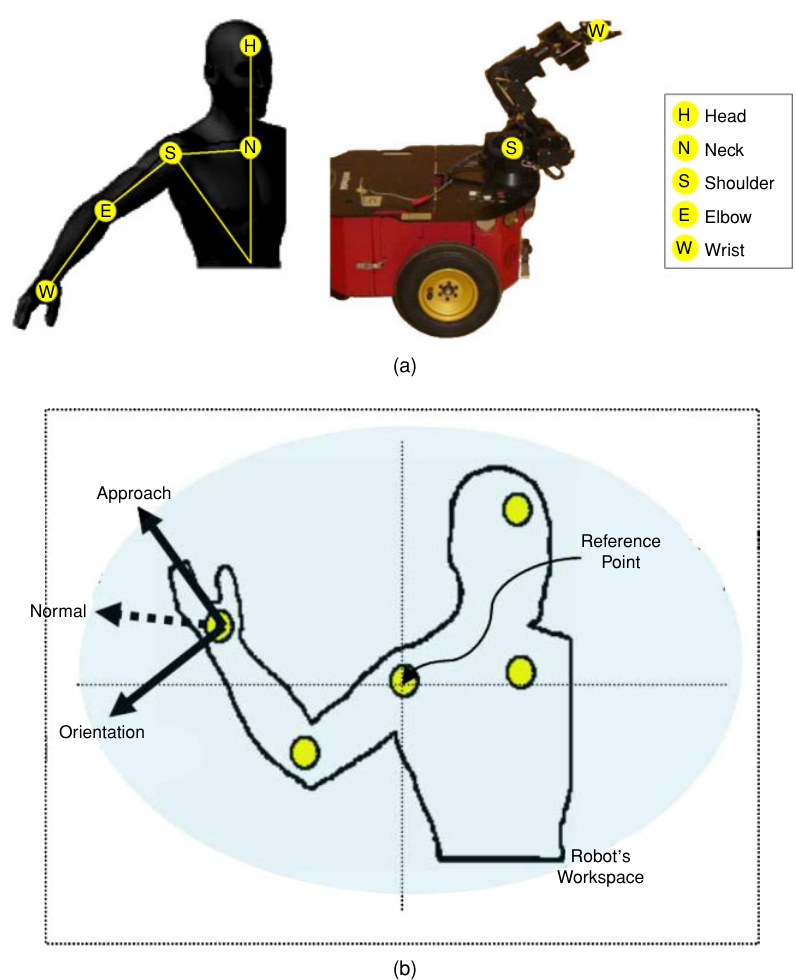
Figure 2 (a) The correspondence between the bodies of the demonstrator (left) and the robot (right). Two joints, the shoulder and the wrist, have correspondence in both bodies. (b) The relation between the image coordinate frame (XY) and the robot coordinate frame